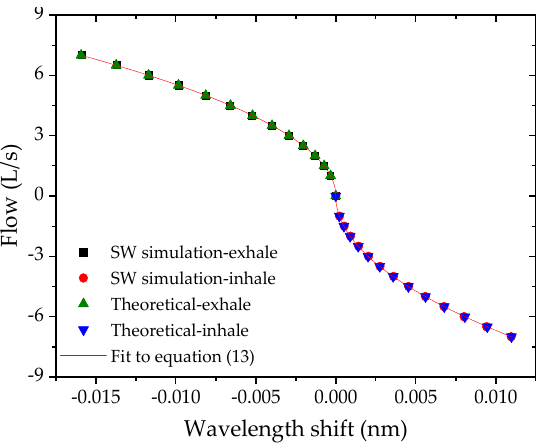
Figure 6. Relation between wavelength shift and flow achieved through SW simulation and theoretical analysis.